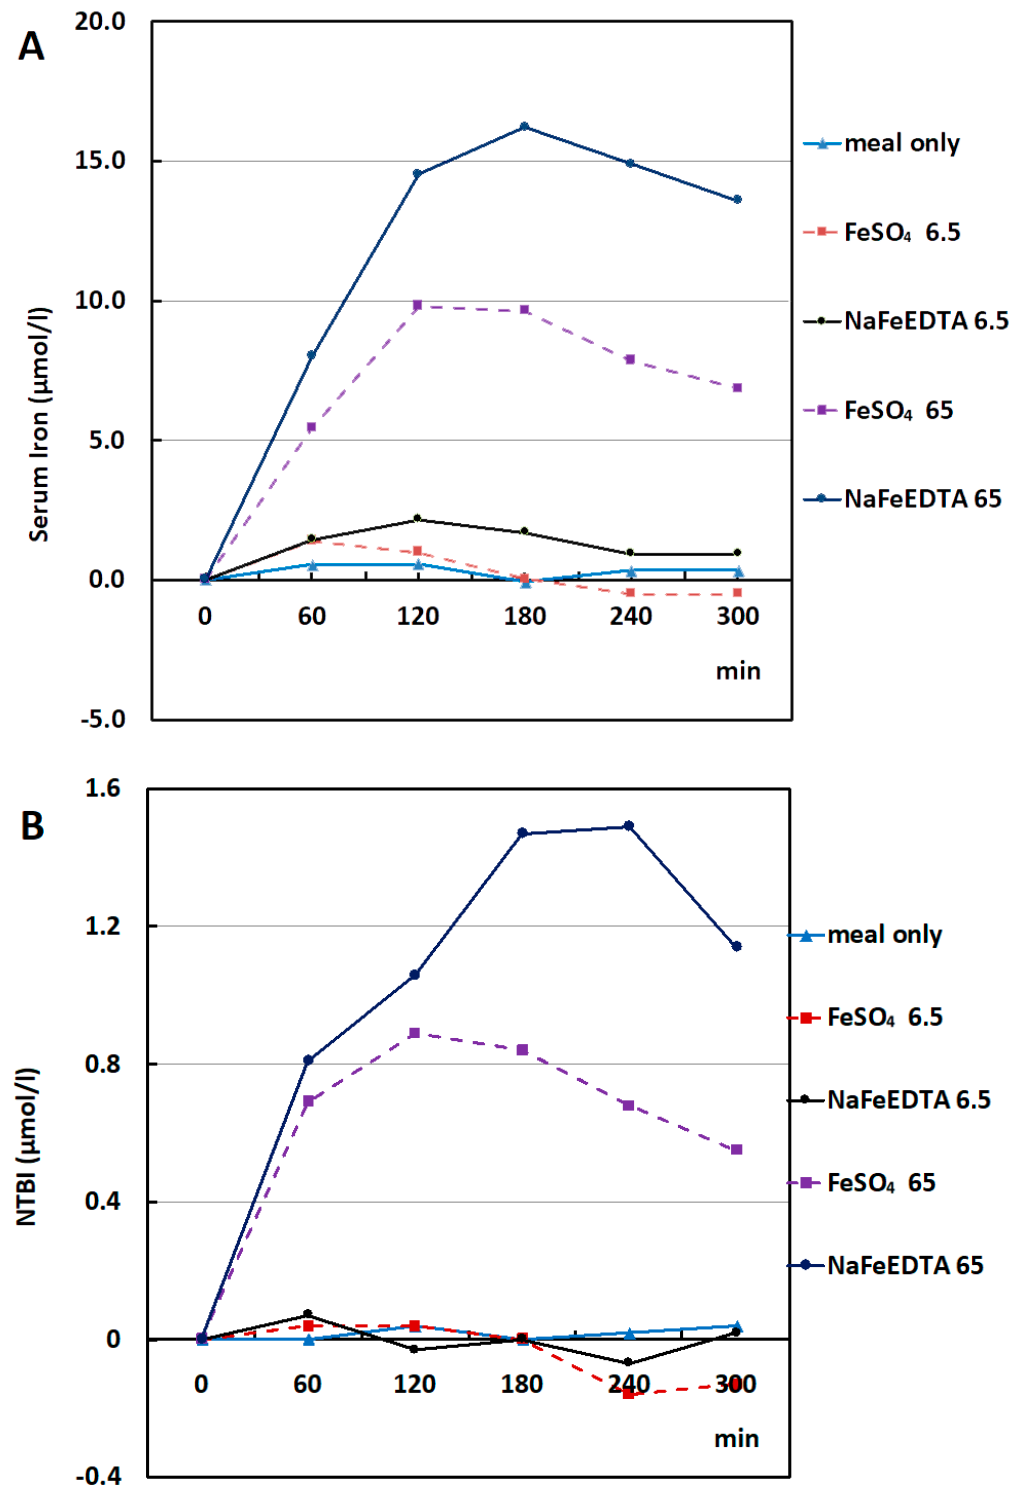
Figure 1. Increase of serum iron ( A ) and serum NTBI ( B ) after 6.5 and 65 mg iron administered after a standard meal as Fe(II)SO 4 or as NaFe(III)EDTA.